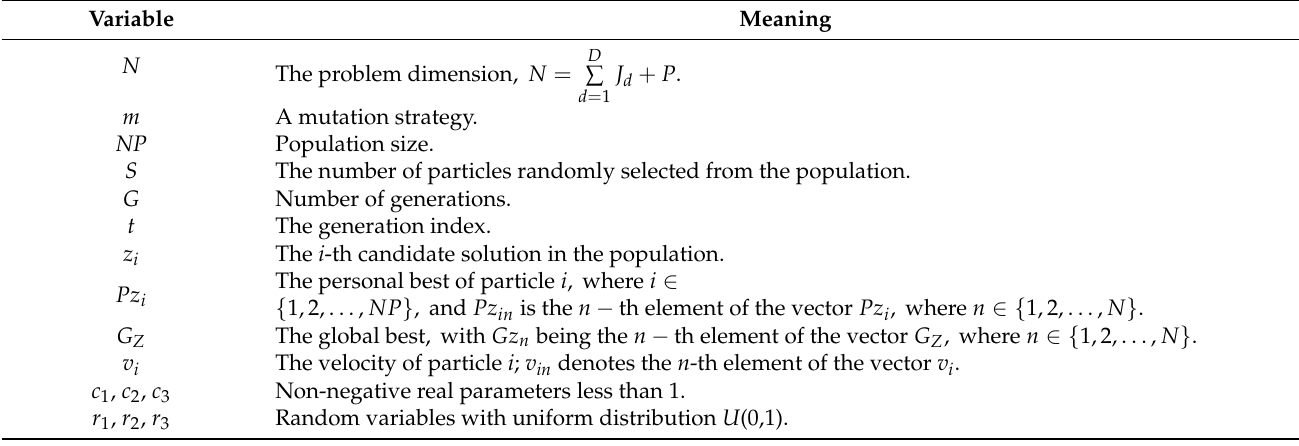
Table 3. Notations of symbols, variables, and parameters used in the three PSO